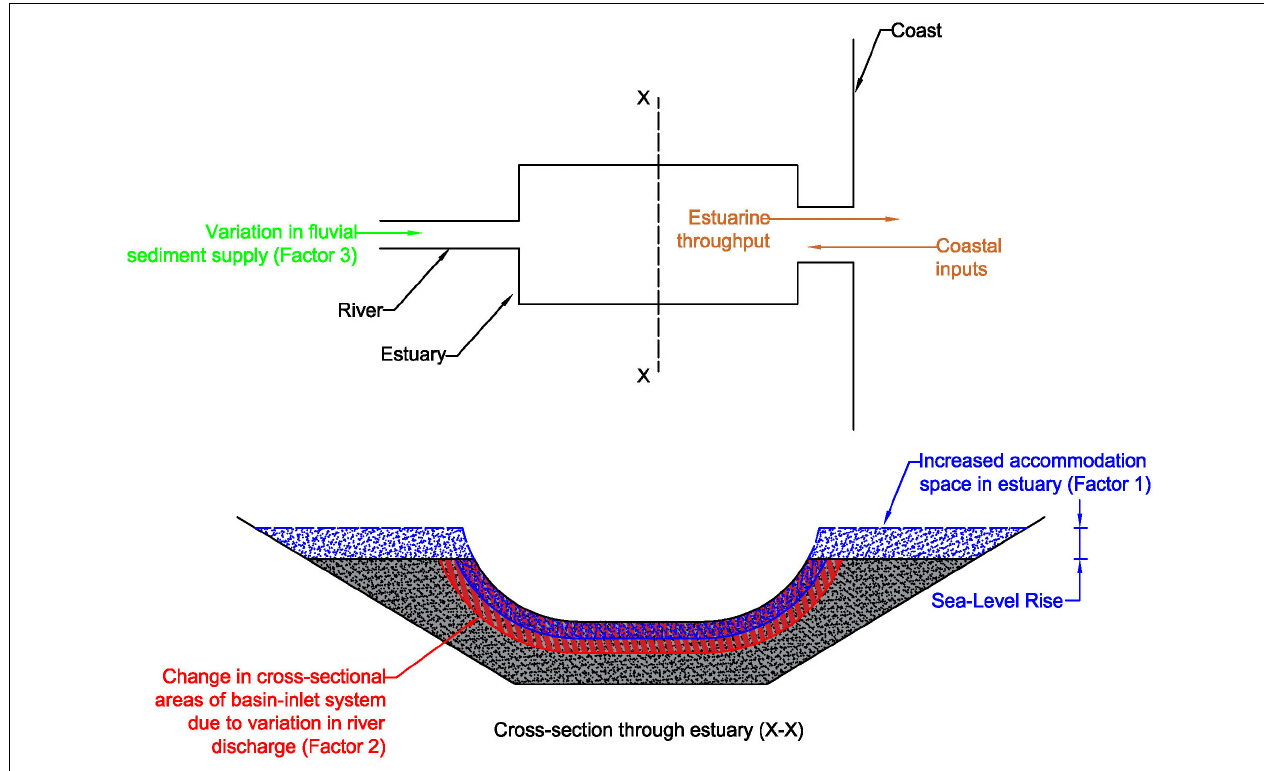
FIGURE 2 | Schematic illustration of the connections between sediment volume components associated with the change in total sediment-volume exchange ( (cid:49) V T ) between inlet-estuary system and its adjacent